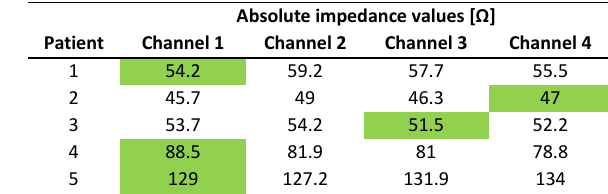
Table 2: The impedance values